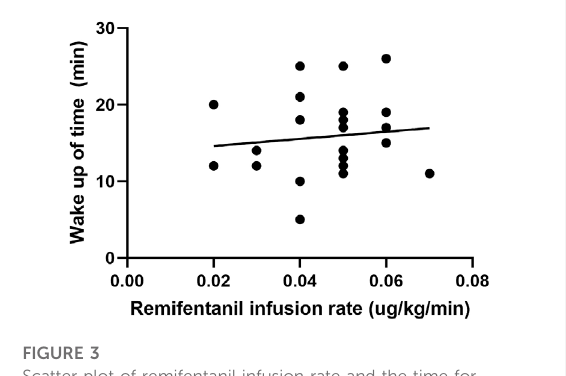
FIGURE 3 Scatter plot of remifentanil infusion rate and the time for awakening in the cough suppression